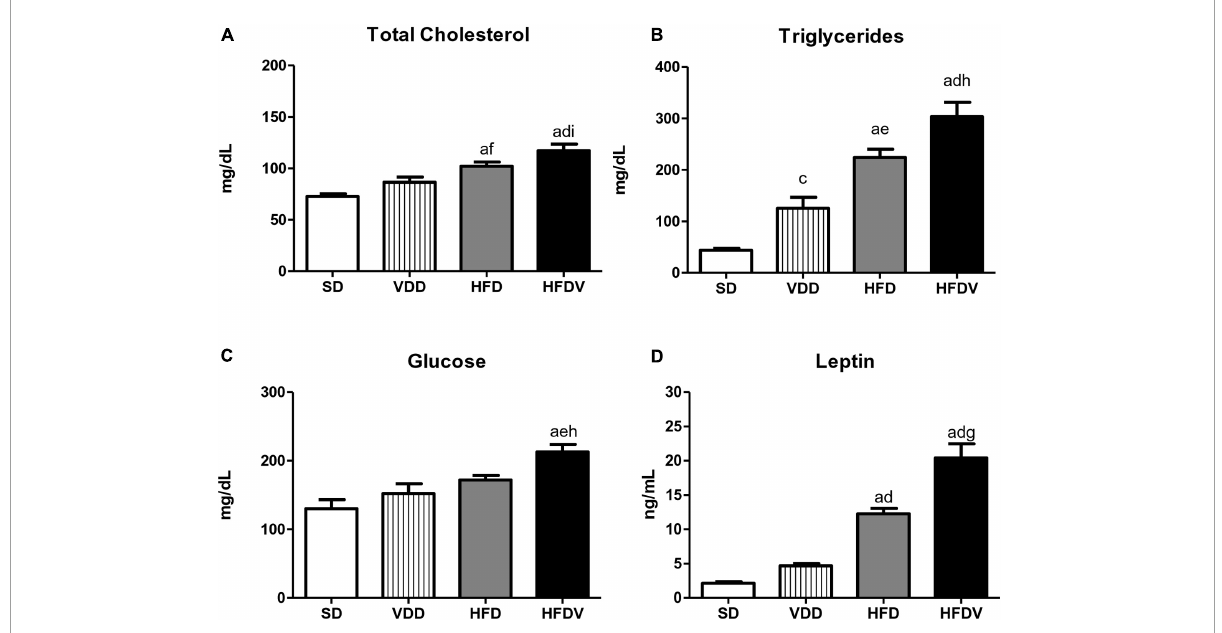
FIGURE2 Plasma concentrations of (A) total cholesterol, (B) triglycerides, (C) glucose, and (D) leptin evaluated after the 90-day protocol in rats submitted to renal ischemia-reperfusion insult on day 45 treated with standard diet (SD), vitamin D-free diet (VDD), high-fat diet (HFD), or high-fat vitamin D-free diet (HFDV). Data are mean ± SEM. a p < 0.001 and c p < 0.05 vs. SD; d p < 0.001, e p < 0.01 and f p < 0.05 vs. VDD; g p < 0.001, h p < 0.01 and i p < 0.05 vs .